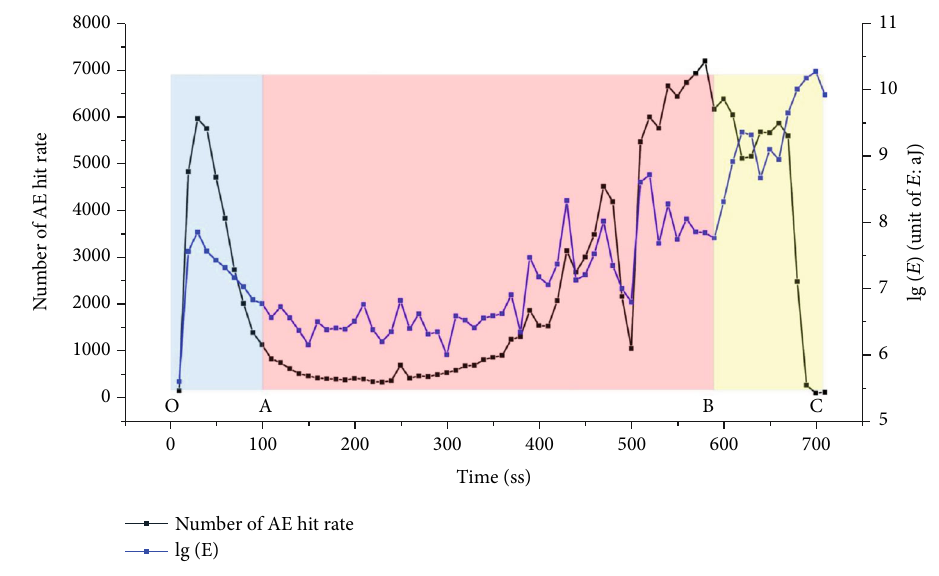
Figure 4: Curves of AE hit rate and energy during loading process.